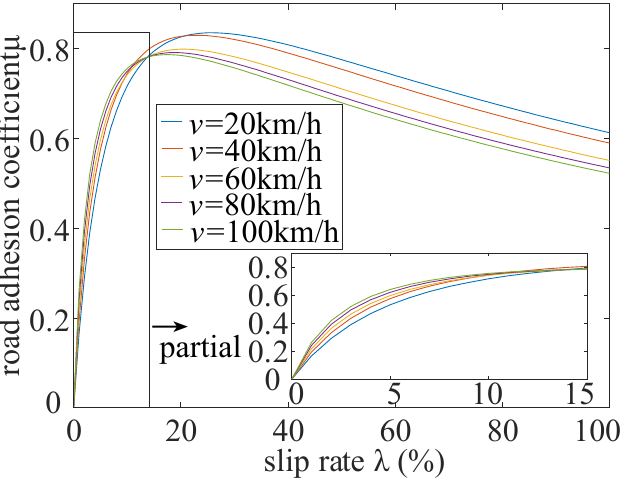
Figure 11. 𝑣 - 𝜆 curve. Figure 11. v - λ curve.